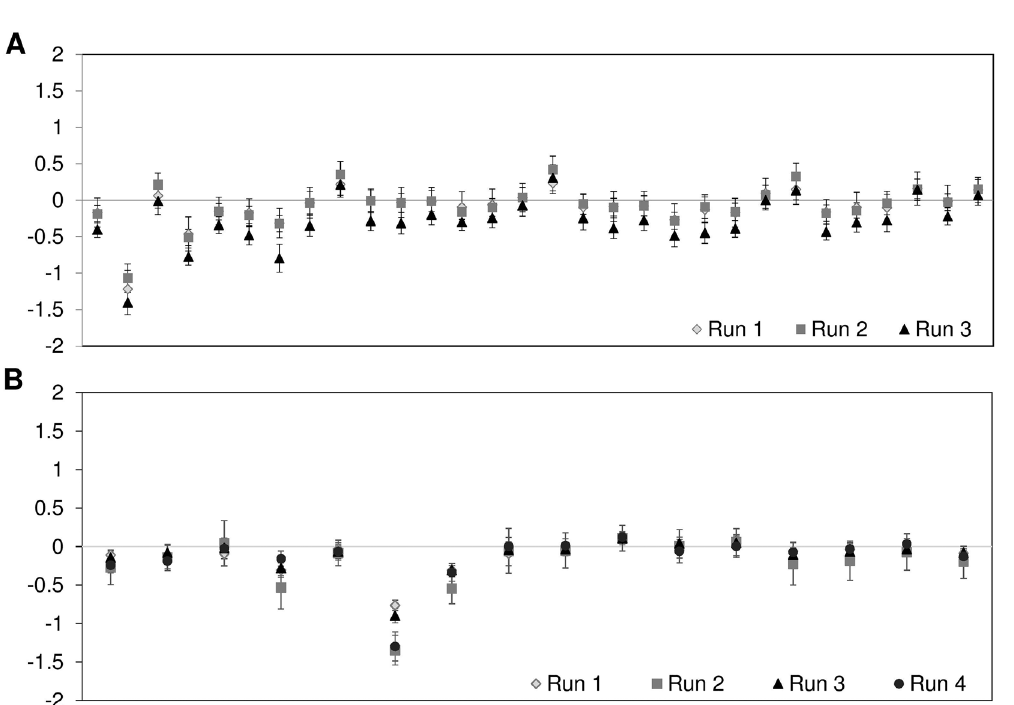
Figure 3 - Reproducibility of assays. (A) Mean relative DoC at 30 amplicons ( GAA gene) of 8 different samples sequenced in 3 different assay runs; (B) MeanrelativeDoCat16amplicons( SMPD1